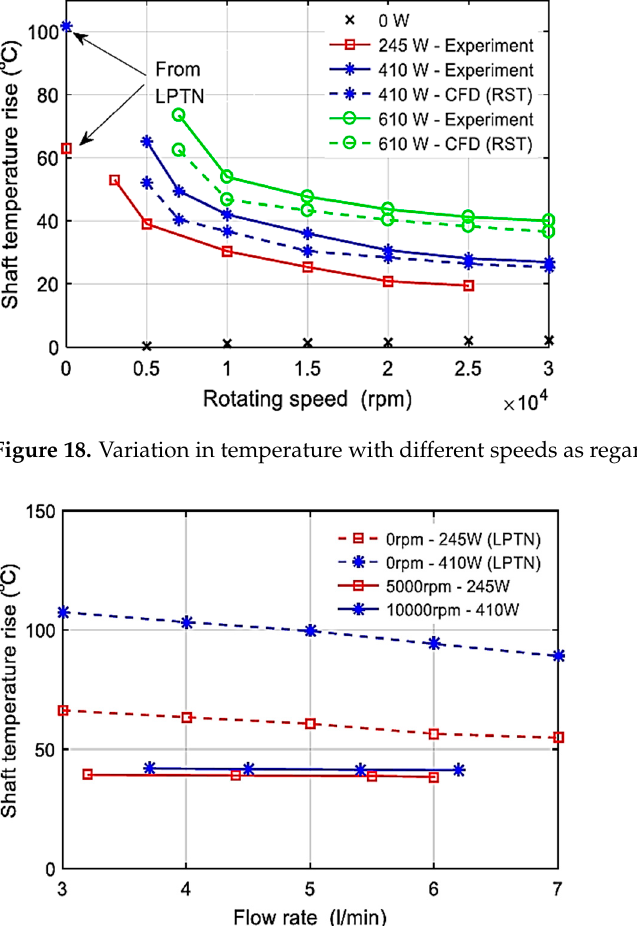
Figure 17. Thermal advantage with the water cold plates compared to water jacket-cooling [81].